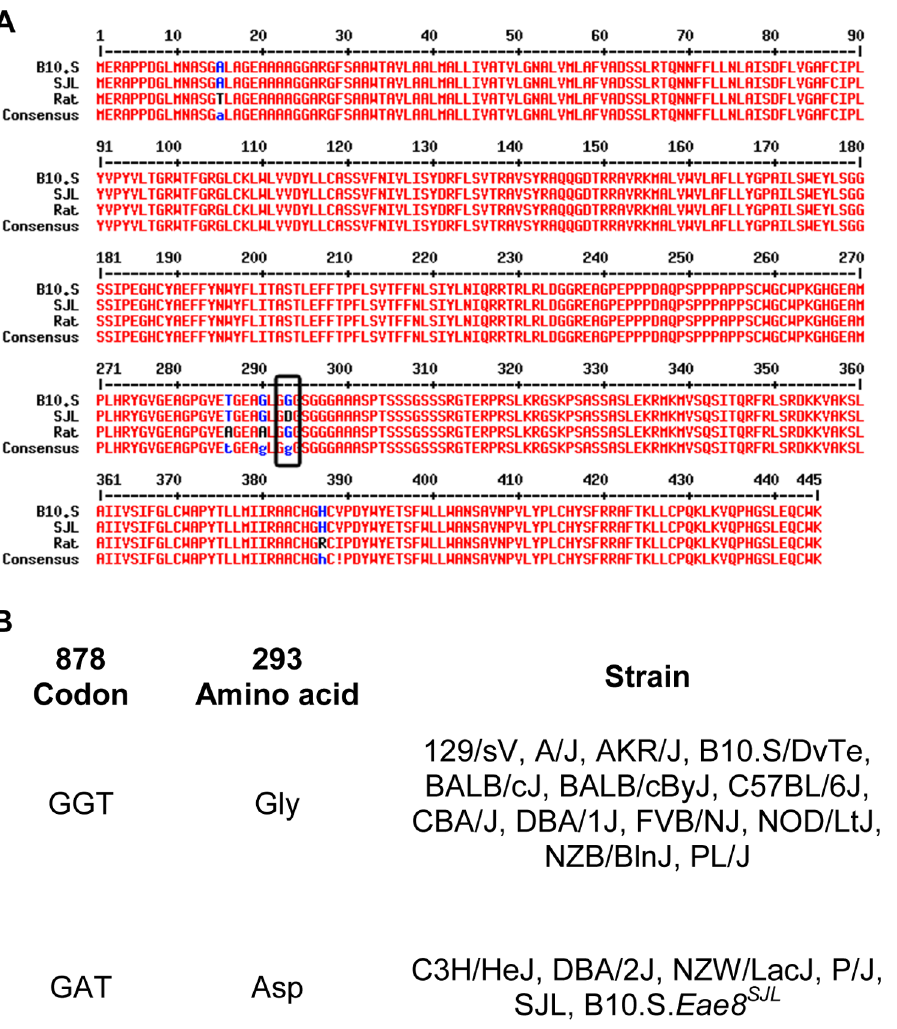
Figure 1. Murine Hrh3 demonstrates a single nucleotide polymorphism. ( A ) Sequence alignment of Hrh3 alleles from B10.S and SJL mice, and rat. Hrh3 cDNAs from the B10.S and SJL mice were amplified, subcloned, and sequenced, as described in the Materials and Methods. ( B ) The strain distribution of the SNP at position 293 in Hrh3 . The presence of the SNP in the indicated strains of mice was determined using restriction typing, as described in the Materials and